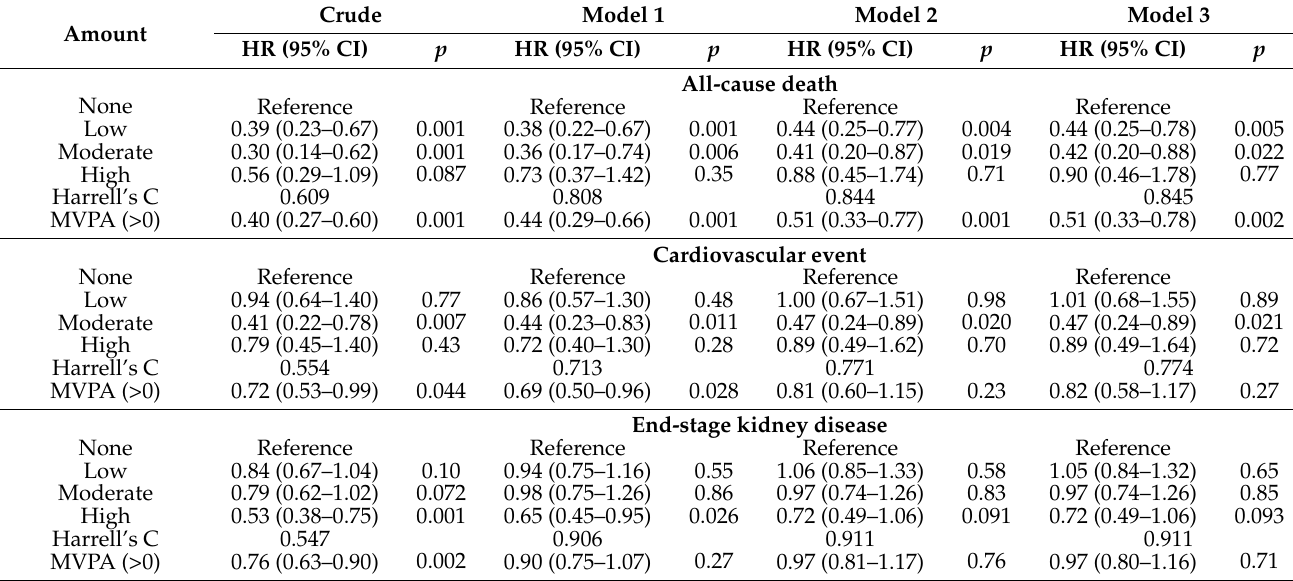
Figure 3. Kaplan–Meier survival curve of ESKD across categories of MVPA amount in adults with nondialysis CKD. Table 3. Hazard ratios (HRs) for clinical outcomes according to the amount of MVPA.